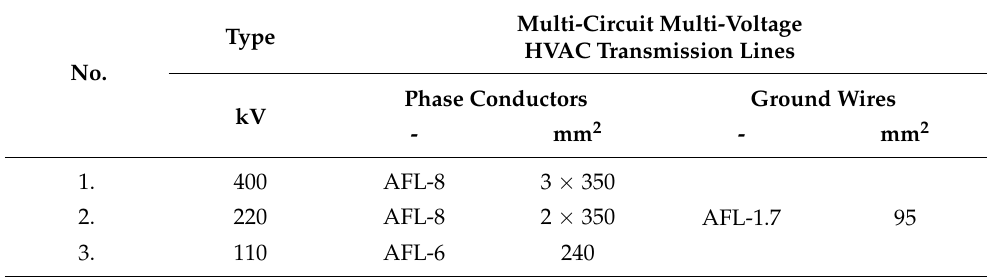
Table 5. The data for the cables used in the modeled multi-system lines with different voltage levels. Type No.